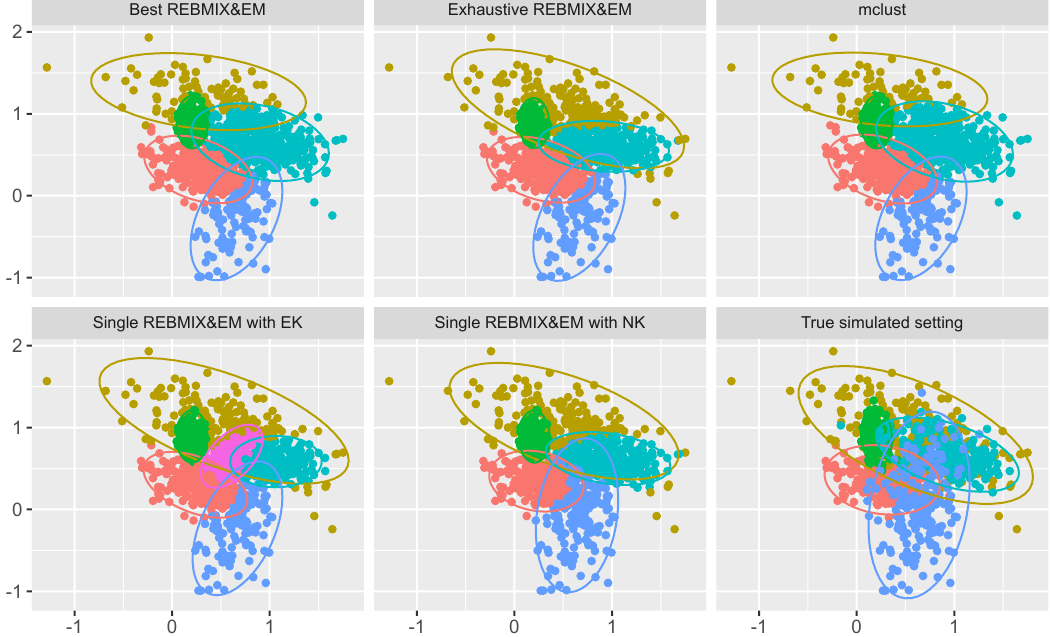
Figure 7. Solutions obtained from different methods used and the true clustering solution on a high overlapping clustering